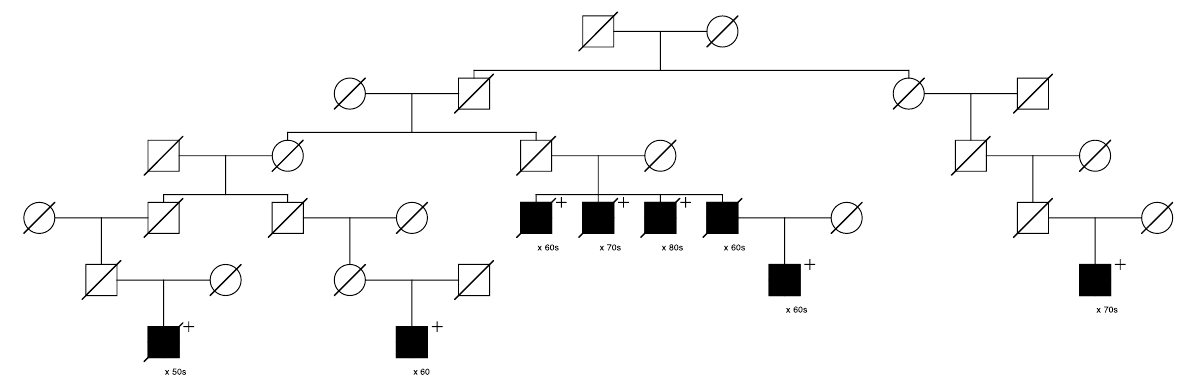
Figure 6. High-risk prostate cancer pedigree segregating a rare BRCA1 variant.